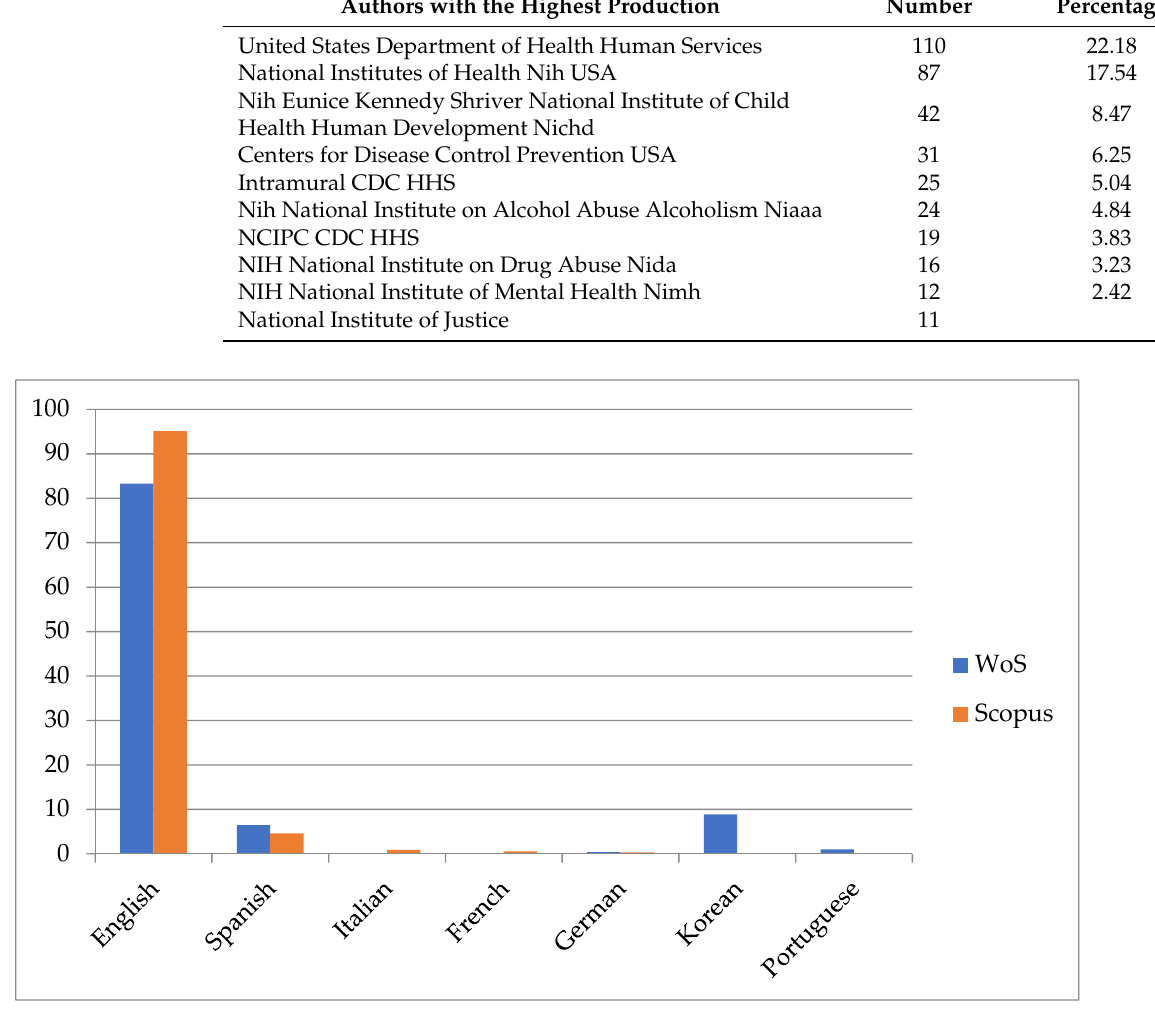
Figure 8. Language of publication.